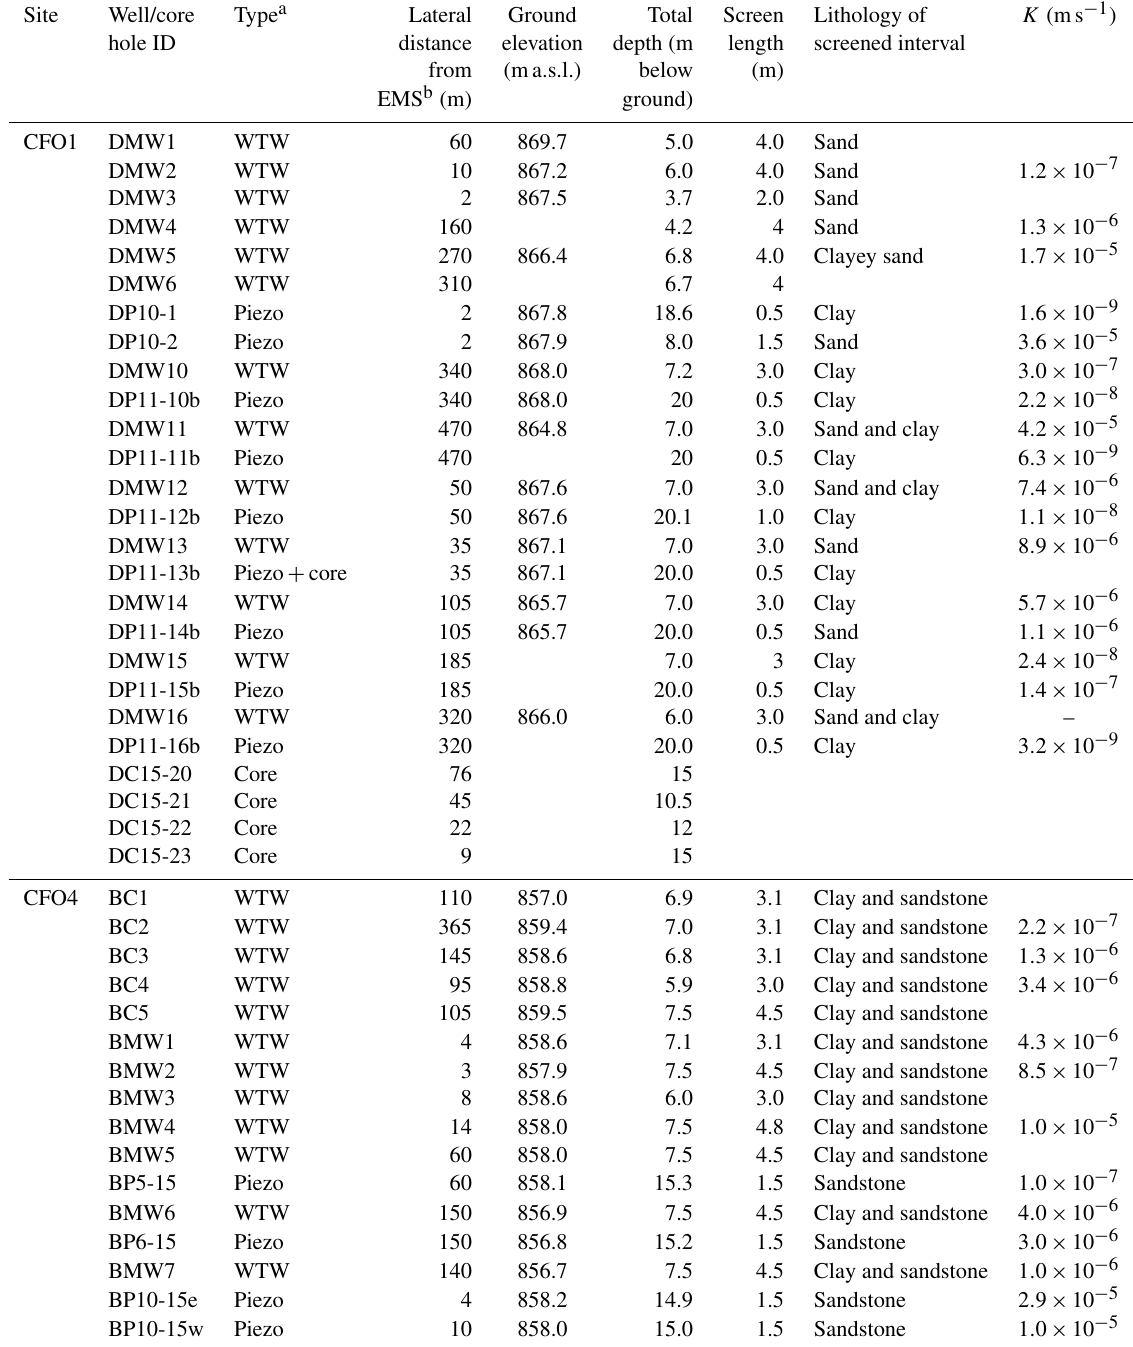
a WTW: water table well, Piezo: piezometer, Core: continuous core. b EMS: earthen manure